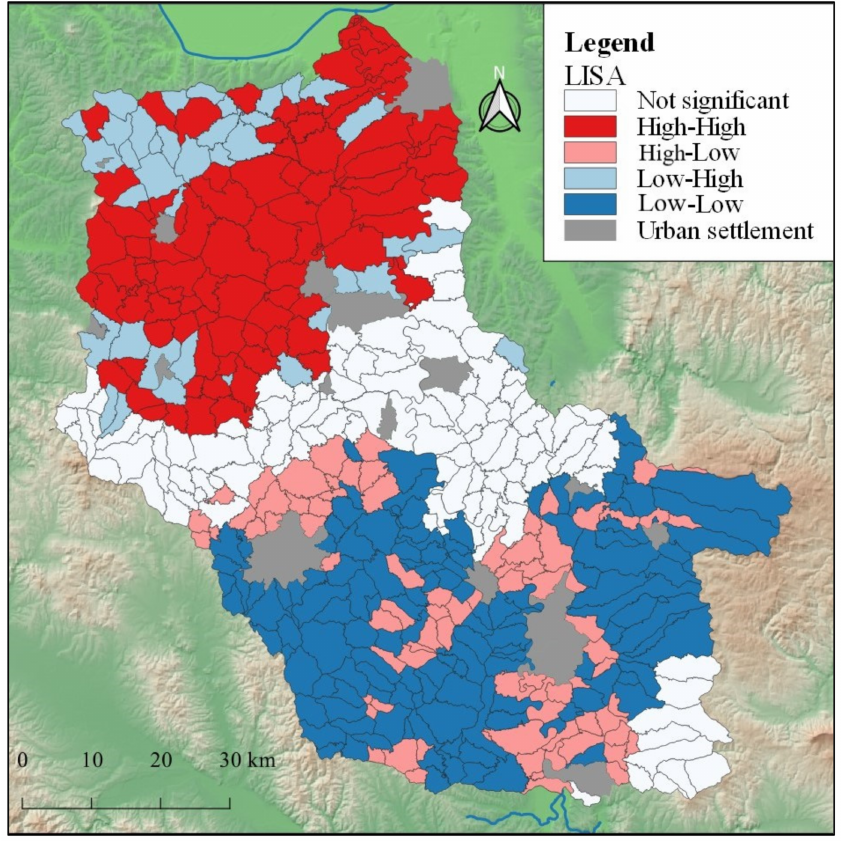
Figure 4. Bivariate LISA cluster map: Index AgL /Index Z